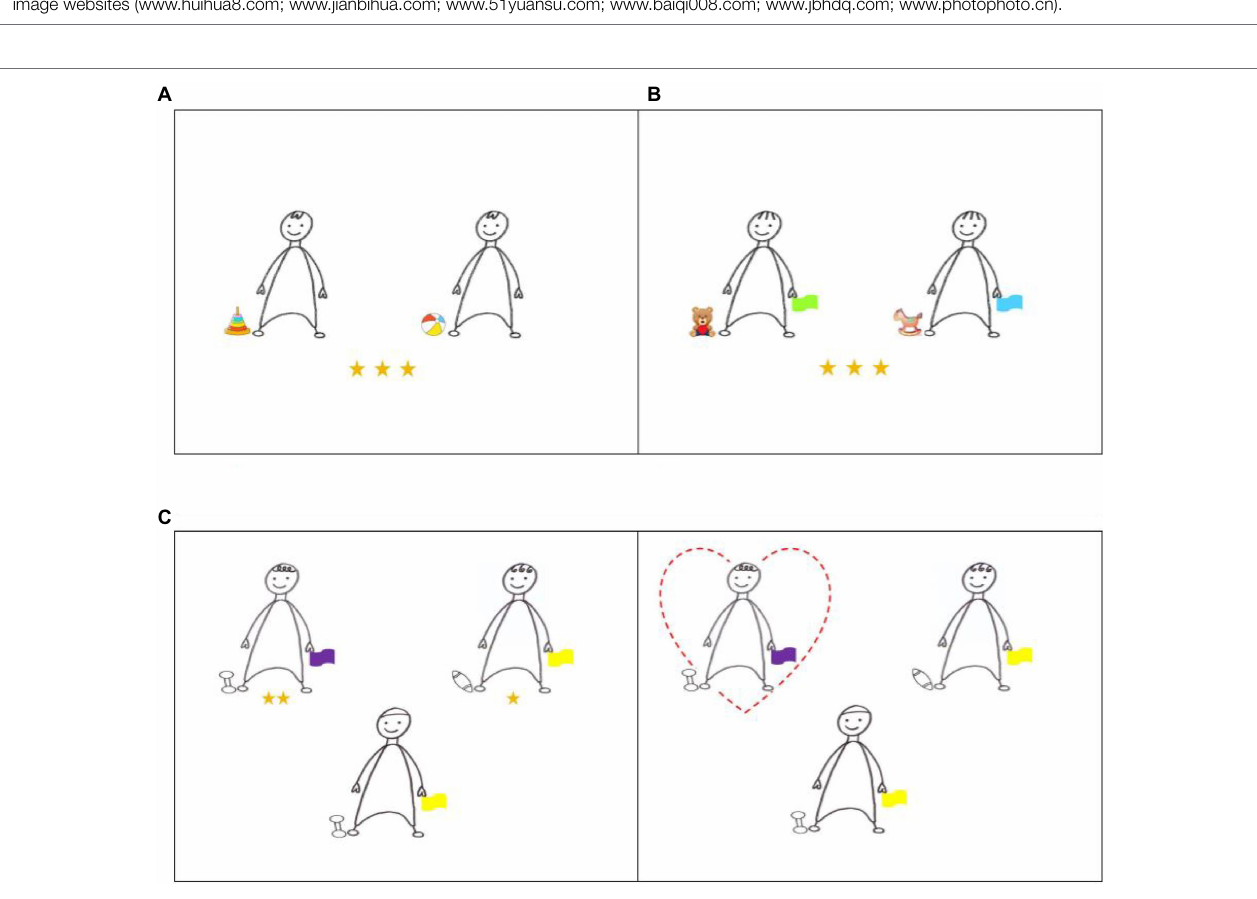
FIGURE 1 | Four pairs of objects of preference used in Tasks 1 and 2. The images of toys and animals used in task 1 and 2 were obtained from the following free image websites (www.huihua8.com; www.jianbihua.com; www.51yuansu.com; www.baiqi008.com; www.jbhdq.com; www.photophoto.cn).